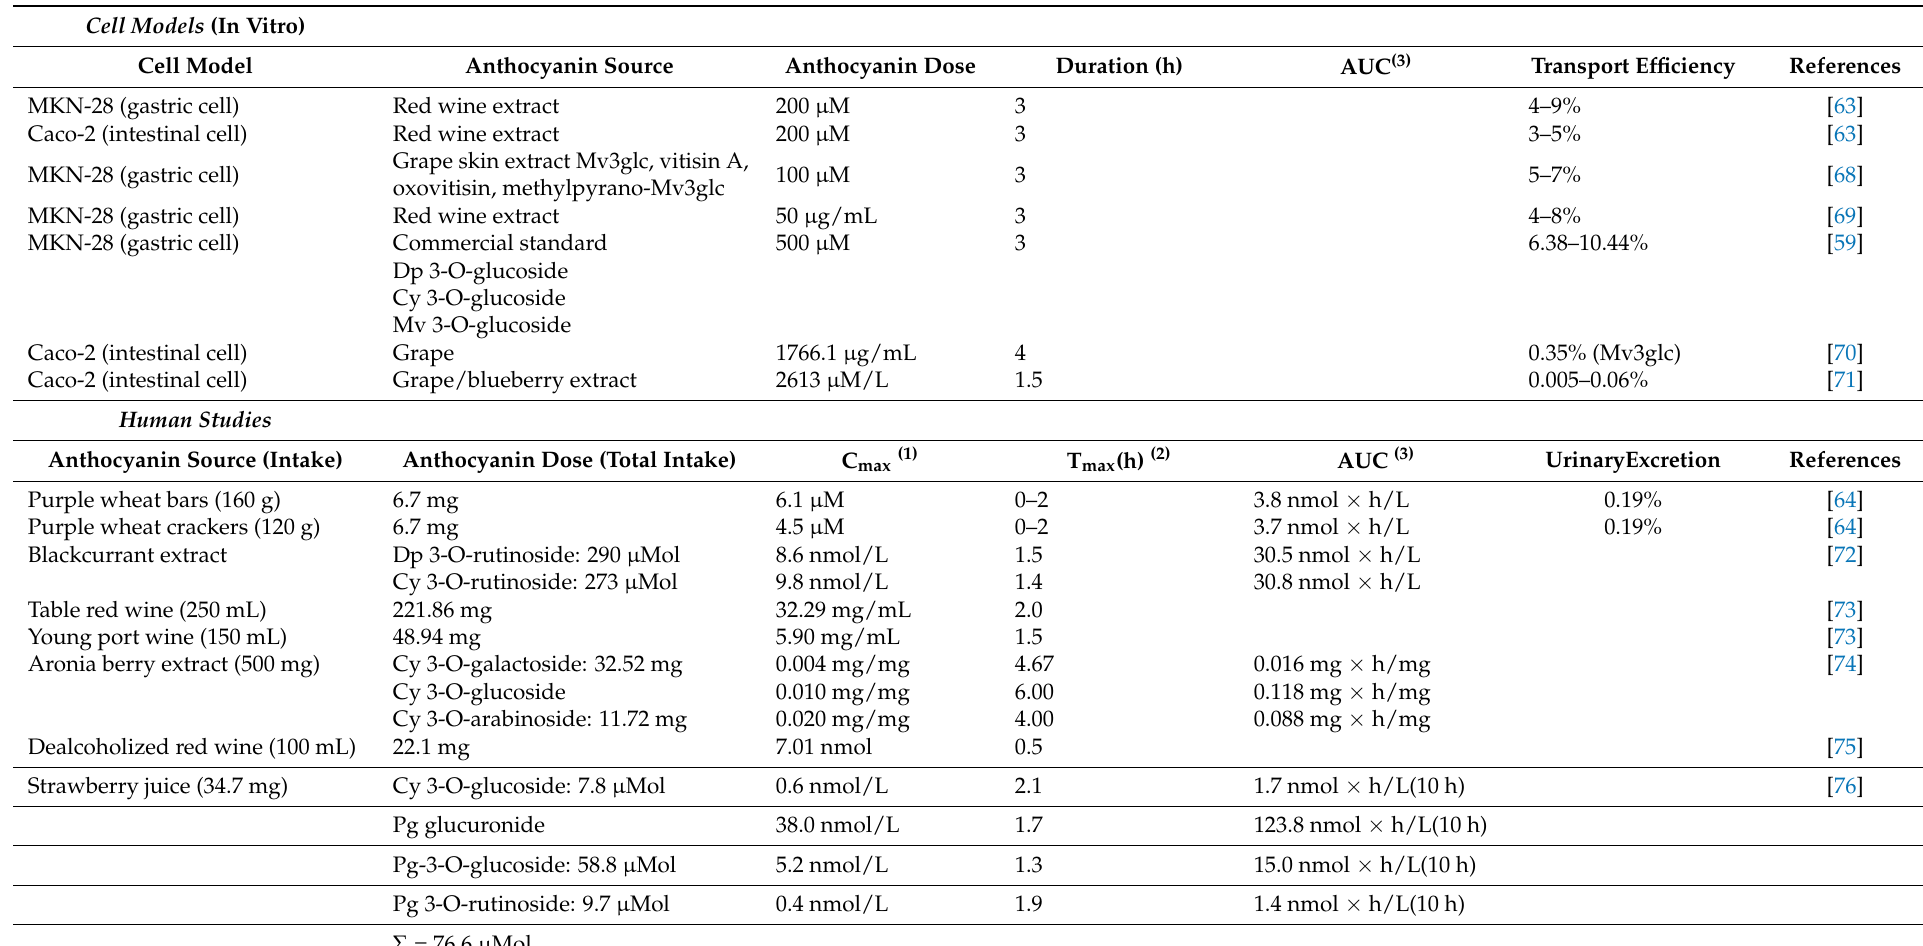
Table 1. Anthocyanins absorption and bioavailability studies using cell line models and human